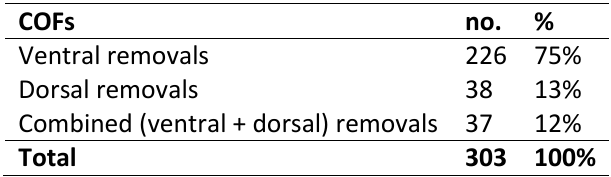
Table 2: Location of removals on